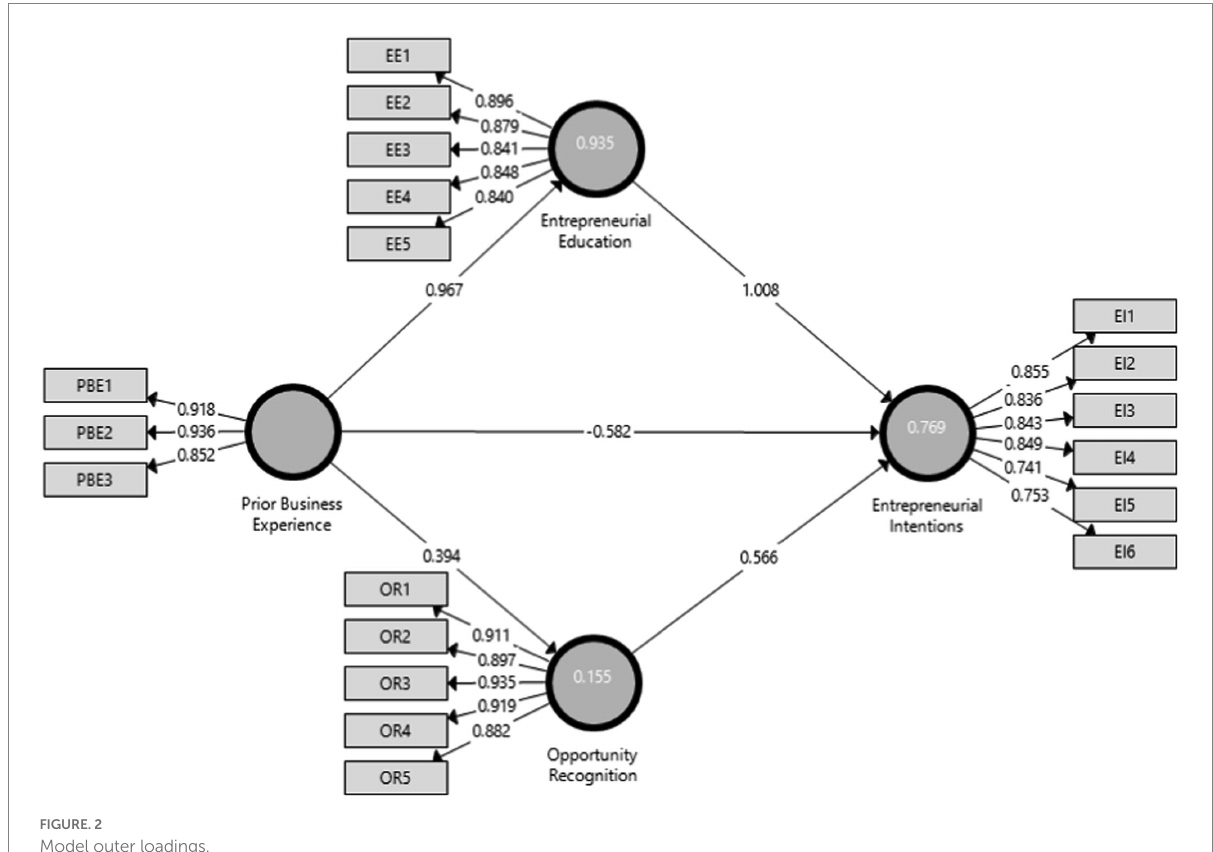
FIGURE. 2 Model outer